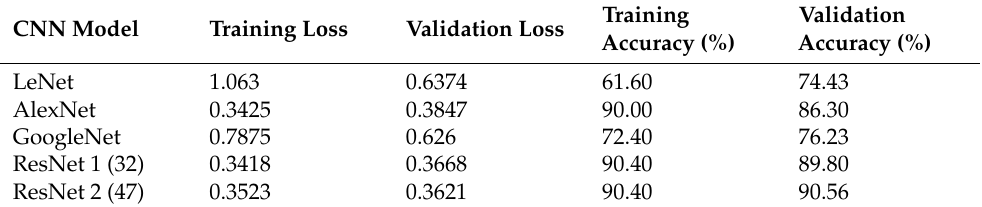
Table 3. Results using proposed minerals segmentation with different CNN models.